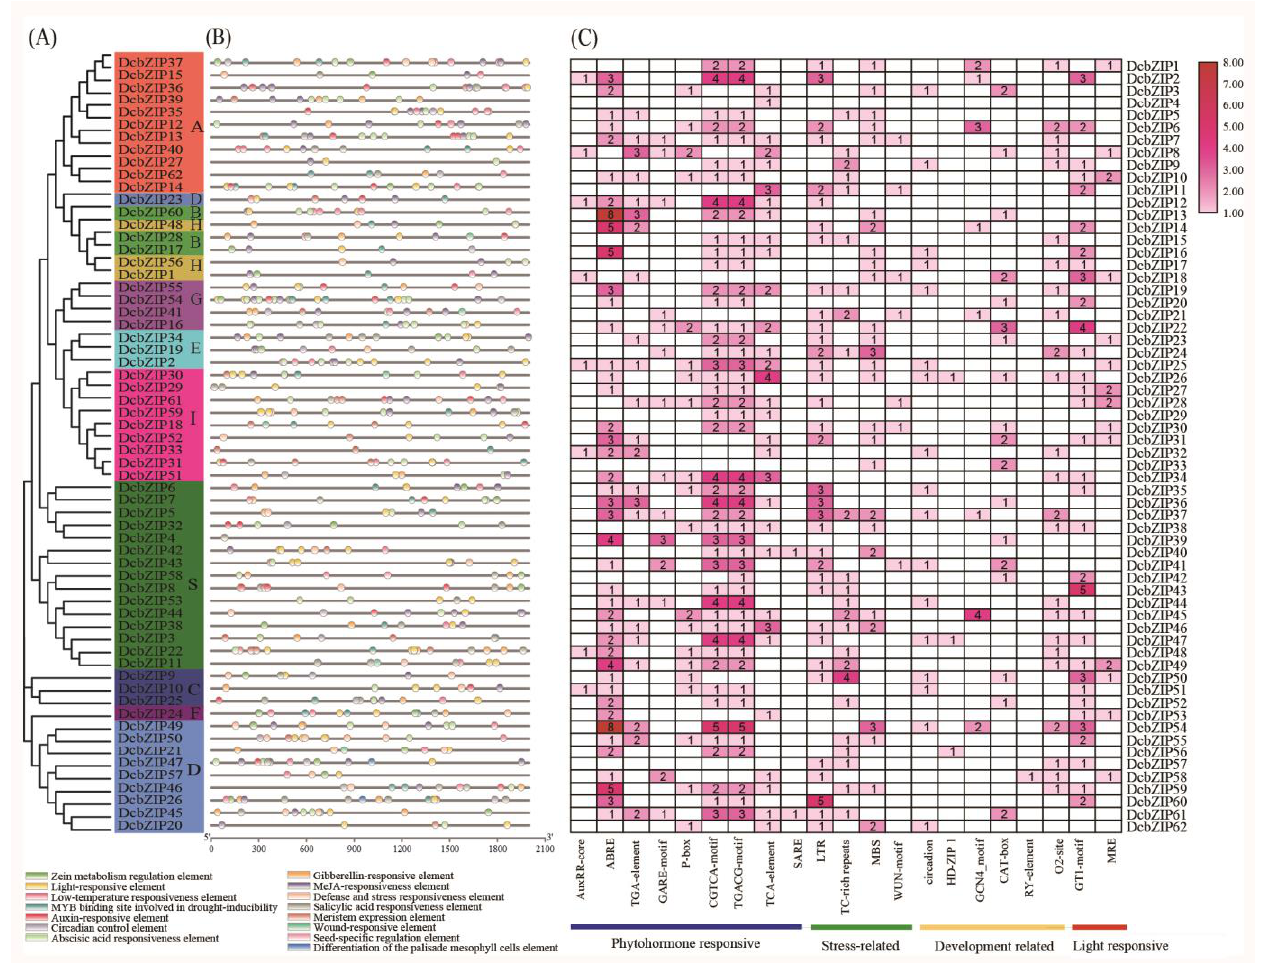
Figure 3. Analysis of cis -elements in the DcbZIP genes promoter regions. ( A ) A phylogenetic tree of 62 DcbZIP proteins was constructed with the ML method. The different subgroups are indicated by different background colors and letters. ( B ) The different colored blocks represent the different types of cis -elements and their locations in each DcbZIP gene. ( C ) The different colors and numbers in the grid indicate the numbers of different promoter elements in the DcbZIP genes. The types, numbers and locations of potential elements in the promoter regions 2-kb upstream of the DcbZIP genes were analyzed by PlantCARE.